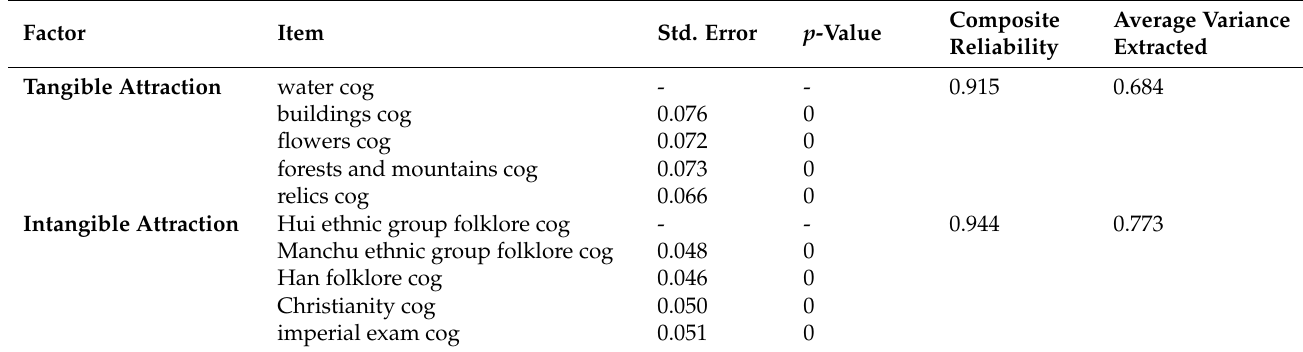
Table 3. CFA of cognition